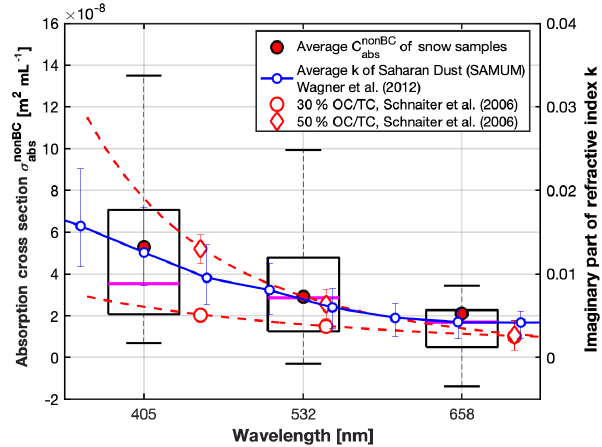
Figure 9. Statistical analysis of the snow mass-specific absorption of the non-BC particles deduced from Eq. (3). cross section σ nonBC abs Laboratory data of the imaginary part of refractive index, k , for Sa- haran dust (blue) and of the absorption cross section of brown car- bon (red) are shown for comparison. Two examples of brown car- bon (BrC) with organic to total carbon mass ratio, OC / TC, of 30% and 50% are selected to emphasize the possible variability in spec- tral absorption of this class of atmospheric aerosol mass. A BrC in snow mass concentration of 4 and 18ngmL − 1 was assumed for the 30% and 50% example,